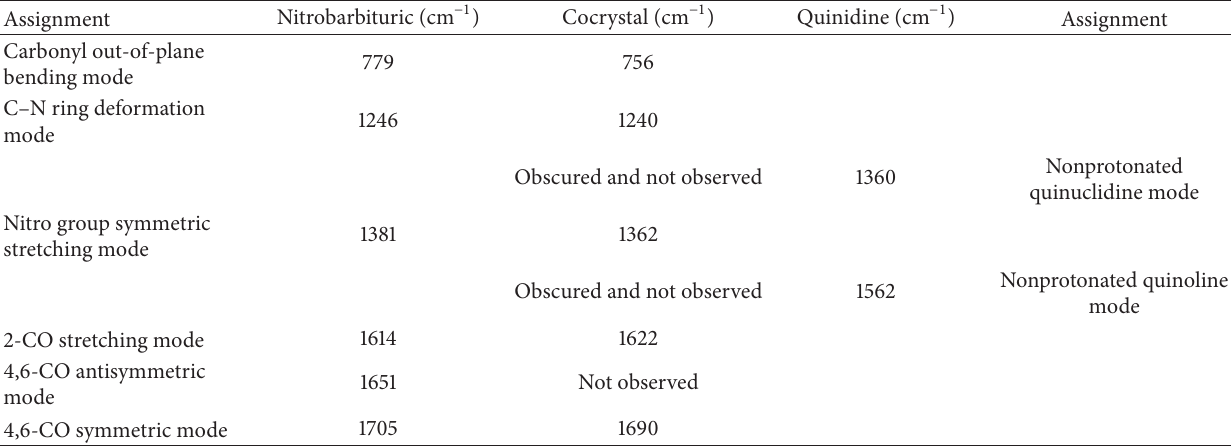
Table 7: Assignments of the major bands in the fingerprint region of the infrared absorption spectra of 5-nitrobarbituric acid, quinidine, and their 1: 1 cocrystal product.